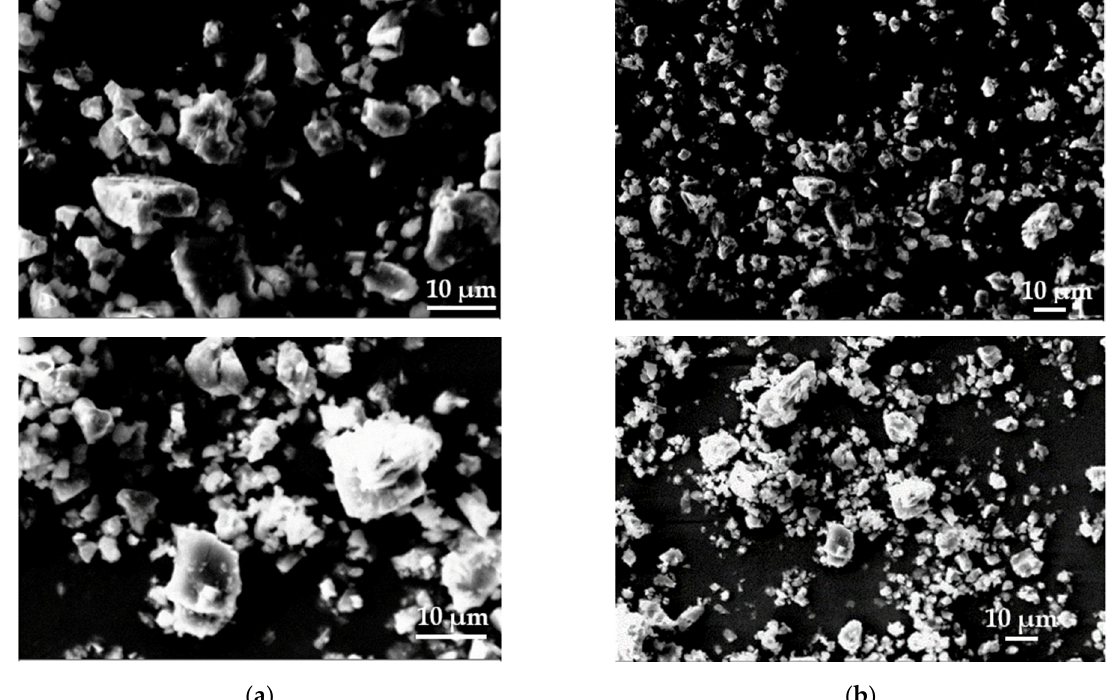
Figure 1. SEM micrographs of CaCO 3 particles at different magnifications ( a ) 5000 × and ( b ) 2000 ×